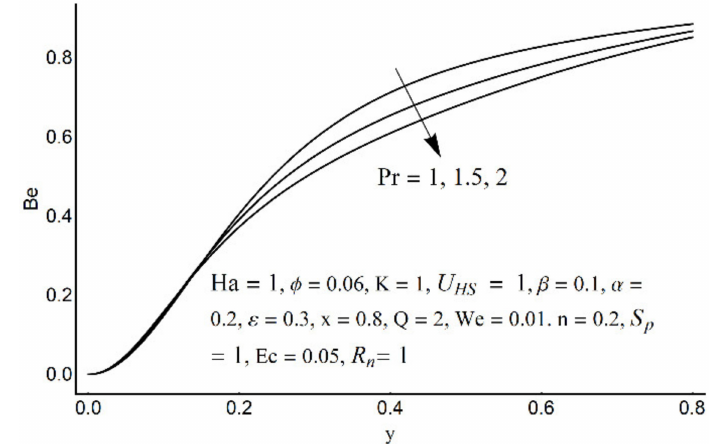
Figure 22. The Bejan number for different values of Pr.